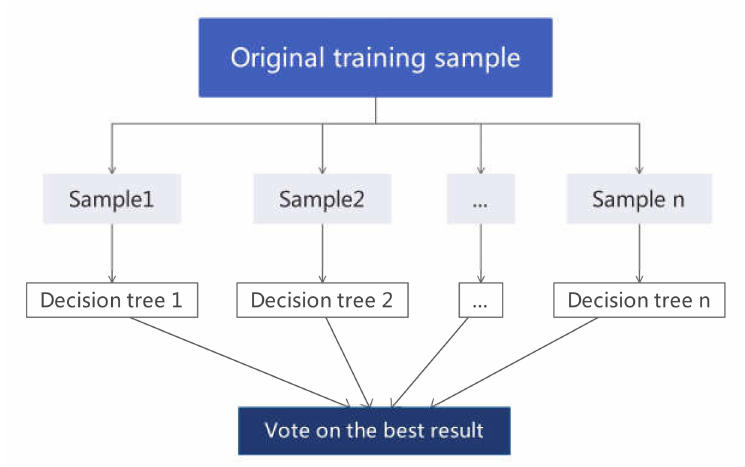
Figure 12. The schematic diagram of the RF